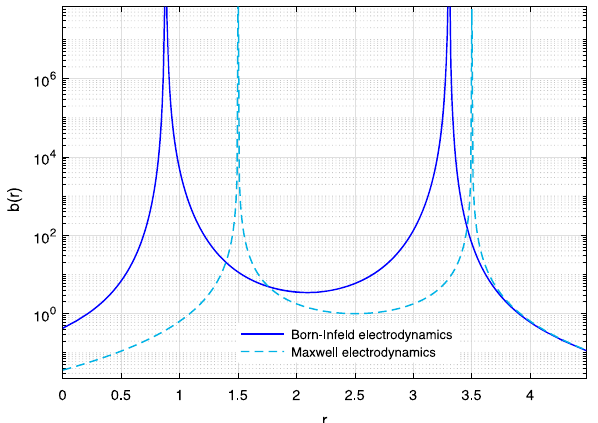
Fig. 3 Normalized magnetic field induction as a function of r . The expressions (30) with the constants c 5 = 4 and c 6 = − 2 . 5 were used as a boundary